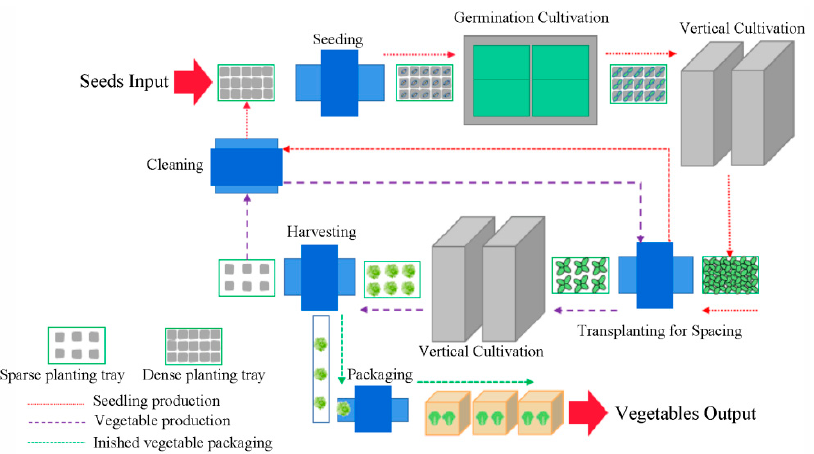
Figure 1. Flowchart of a type of vegetable production in a plant.